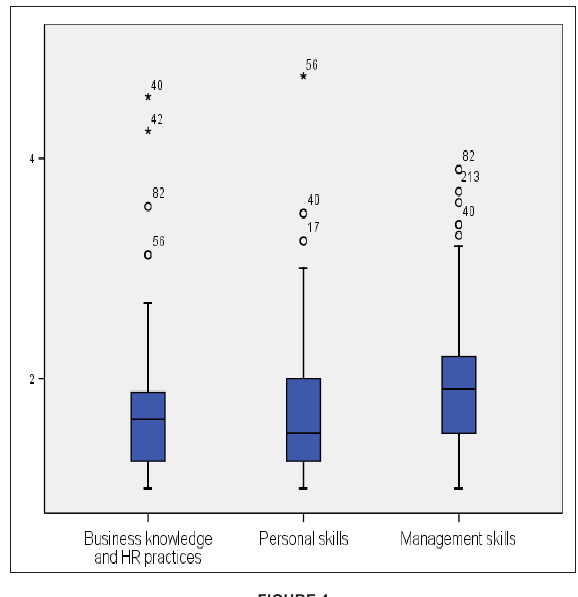
FiguRE 4 Box plots for the importance factors